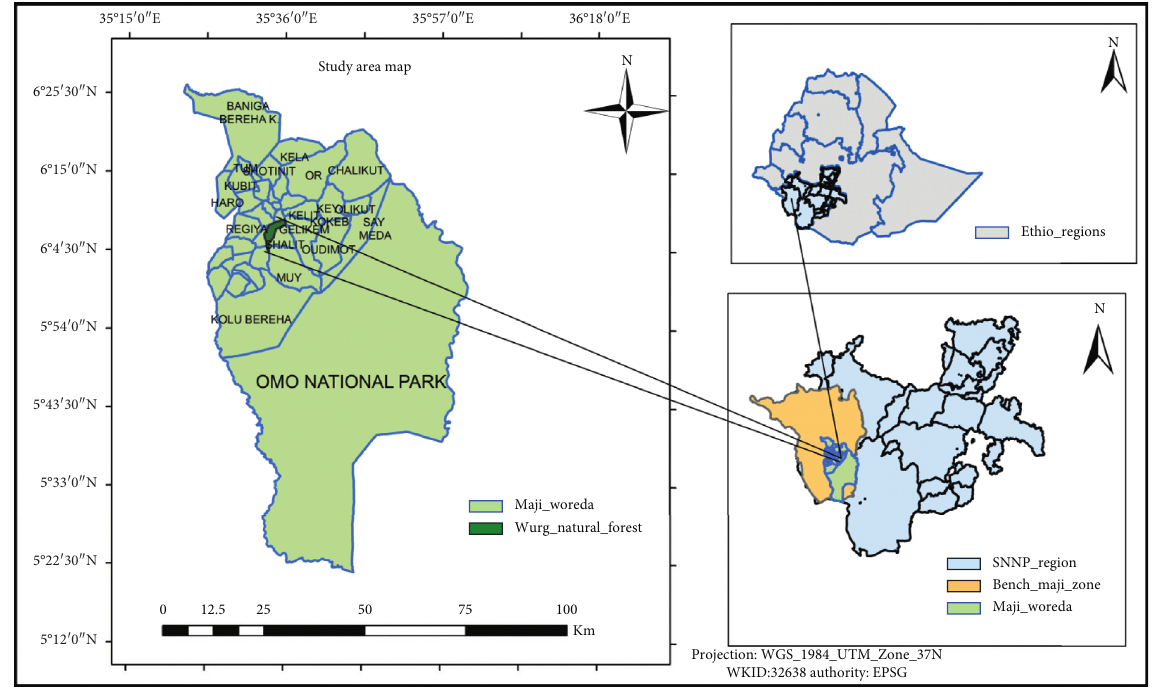
Figure 1: Location map of the study area.